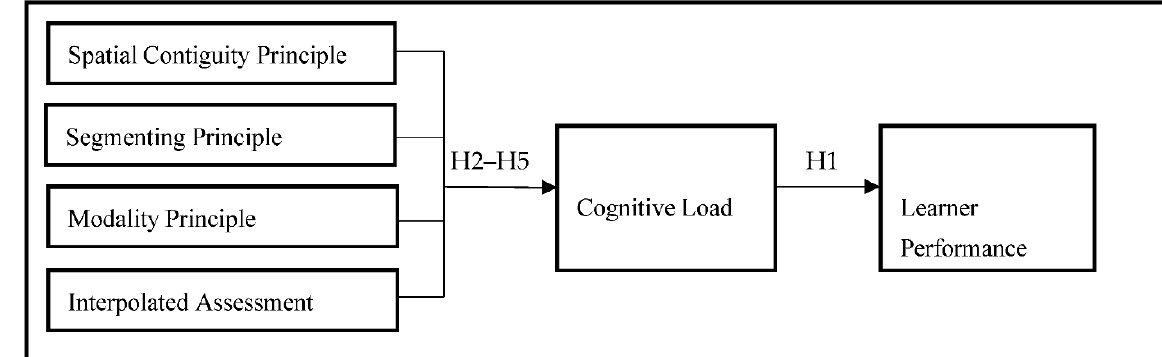
Figure 1. The proposed framework H1: Cognitive load influences learner performance. H1: Cognitive load influences learner